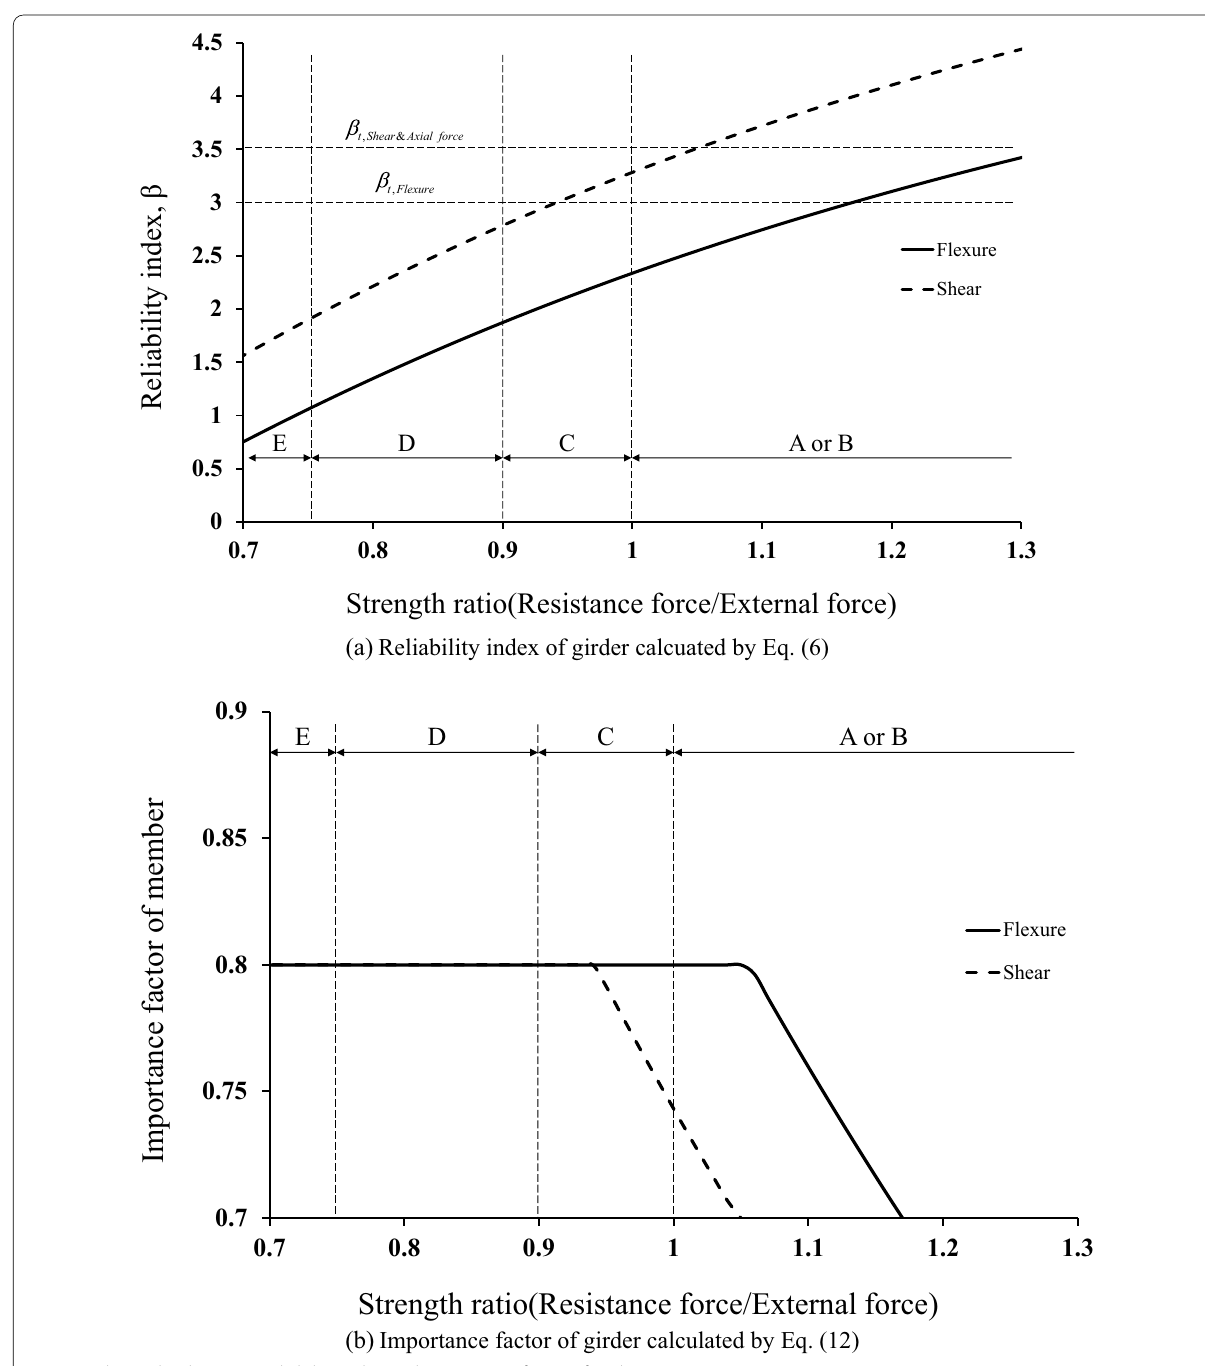
Fig. 7 Relationship between reliability index and importance factor of